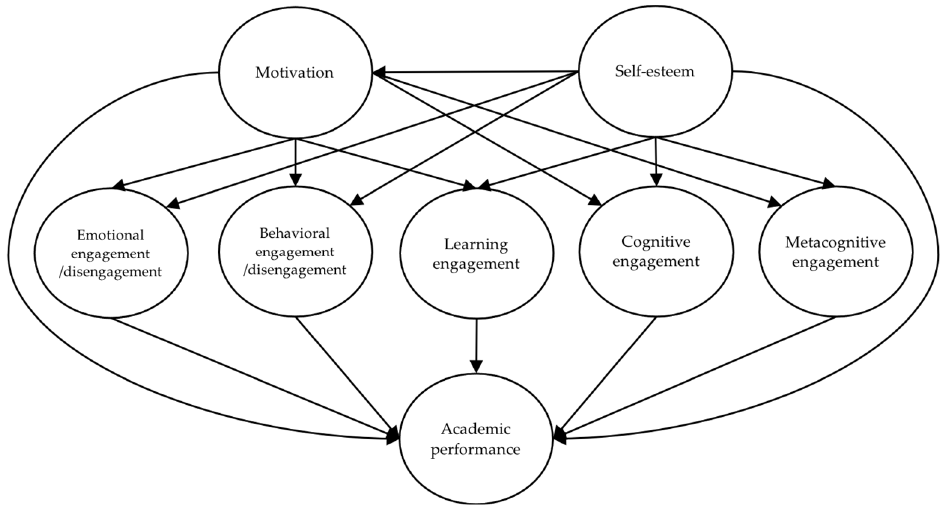
Figure 1. Proposed conceptual model.